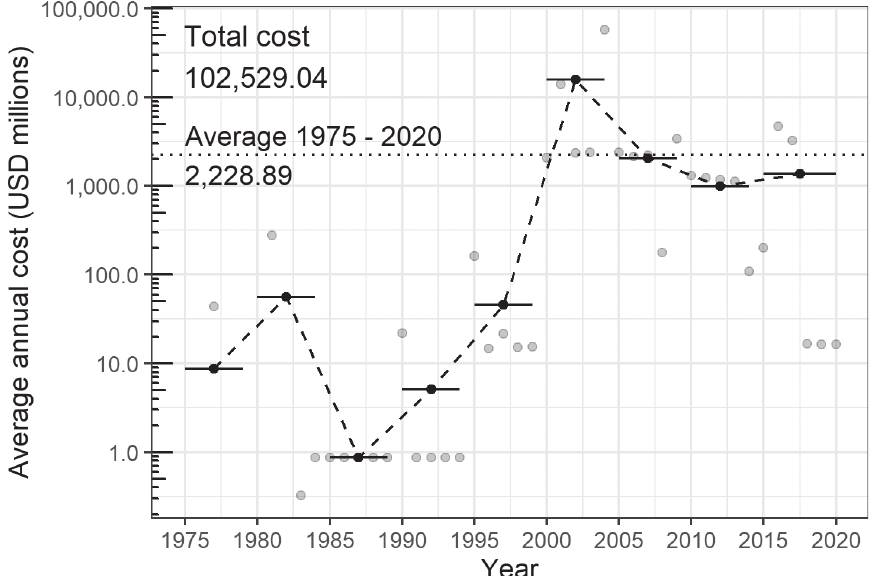
Figure 2. Annual costs of biological invasions observed over time in Central and South America. Grey dots represent the annual costs, horizontal lines and black dots represent the average annual cost per 5 years and the dashed horizontal line represents the general average between 1975 and 2020.